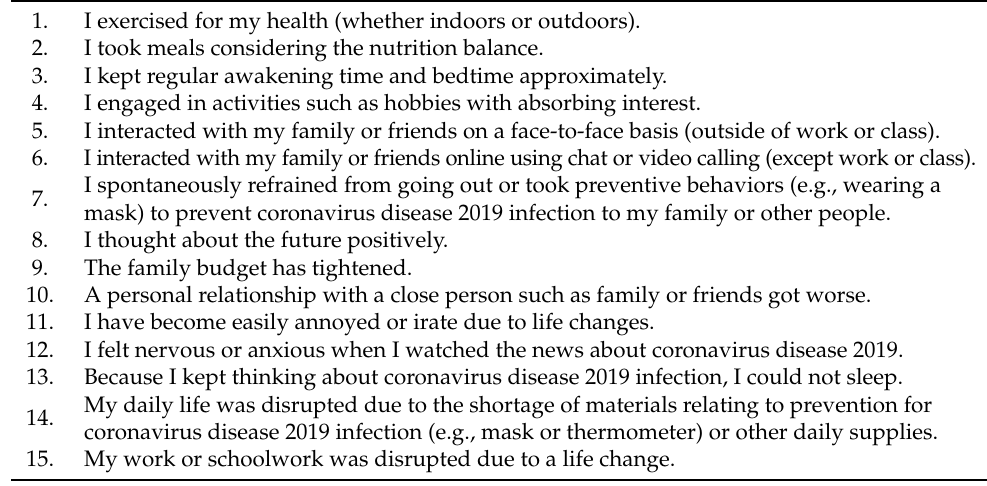
Table 1. Items about lifestyle, coping behavior, and stressors related to mild